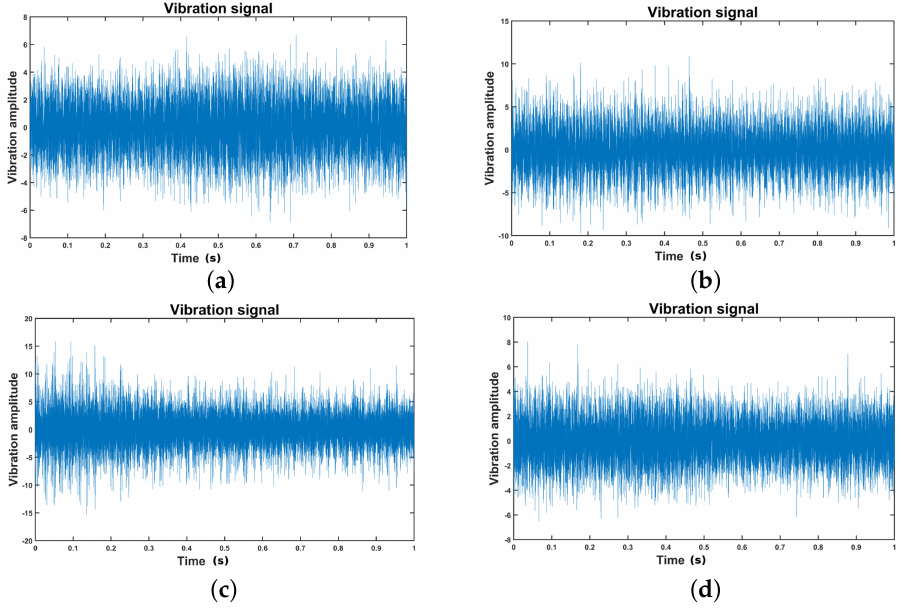
Figure 3. Vibration signals from the CP dataset. ( a ) Signal from class P1. ( b ) Signal from class P6. ( c ) Signal from class P10, ( d ) Signal from class P13.